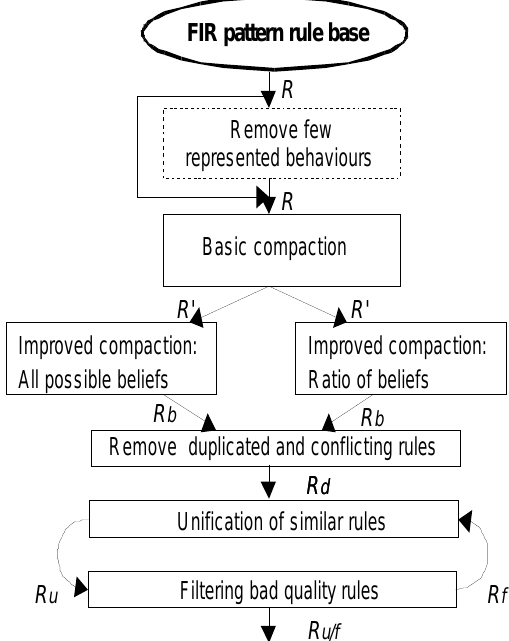
Fig. 4. Main steps of the LR-FIR